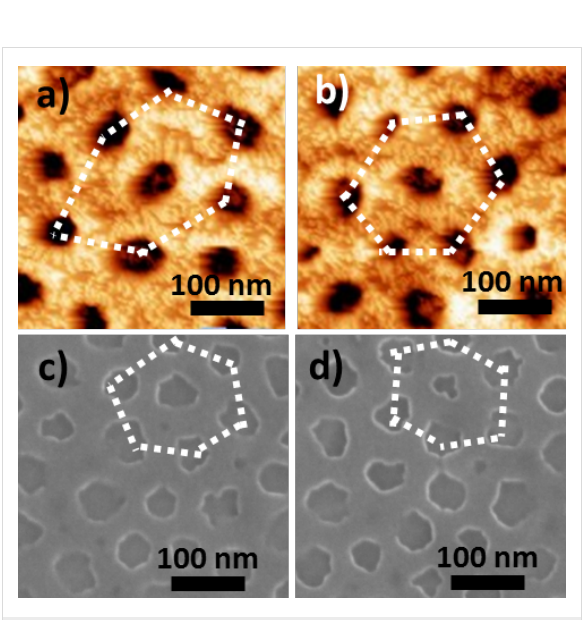
Figure 4: AFM images of a) Au20NC , b) Au50NC and SEM micro- graphs of c) Au20NC and d) Au50NC